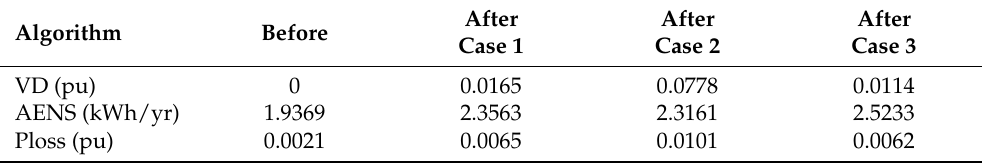
Table 11. Distribution network parameters before and after charging station